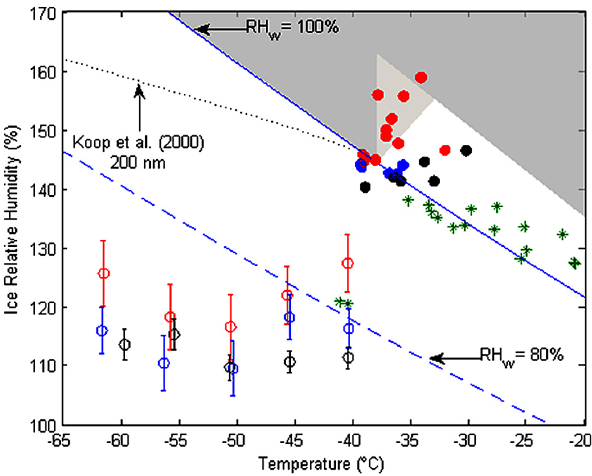
Fig. 1. Conditions for ice nucleation on 1% of ATD particles as a function of temperature for sizes: 200nm (red), 300nm (blue), 400nm (black). Open symbols represent data collected with the laboratory unit and filled symbols represent data collected with the aircraft unit. Green stars represent conditions for ice nucleation on 1% of polydisperse ATD particles during ICIS. The dark gray shad- ing indicates the region where droplets are known to be counted by the OPC in the CFDC systems. The light gray shading indicates the transition where the state of the particle counted by the OPC is ambiguous. Water saturation, RH w = 80% and the conditions for which 200nm (NH 4 ) 2 SO 4 particles nucleate ice according to Koop et al. (2000) are indicated in the figure for